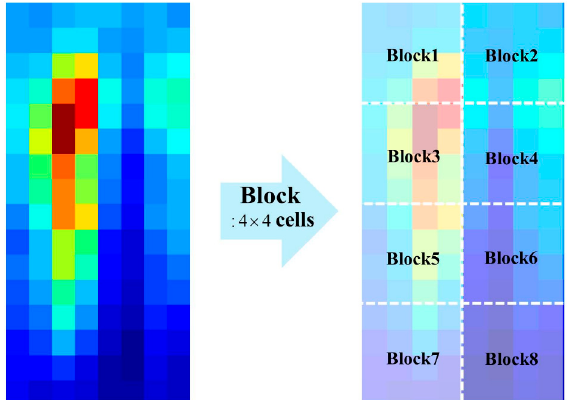
Figure 4. Example of HOG channels with 9 orientations.